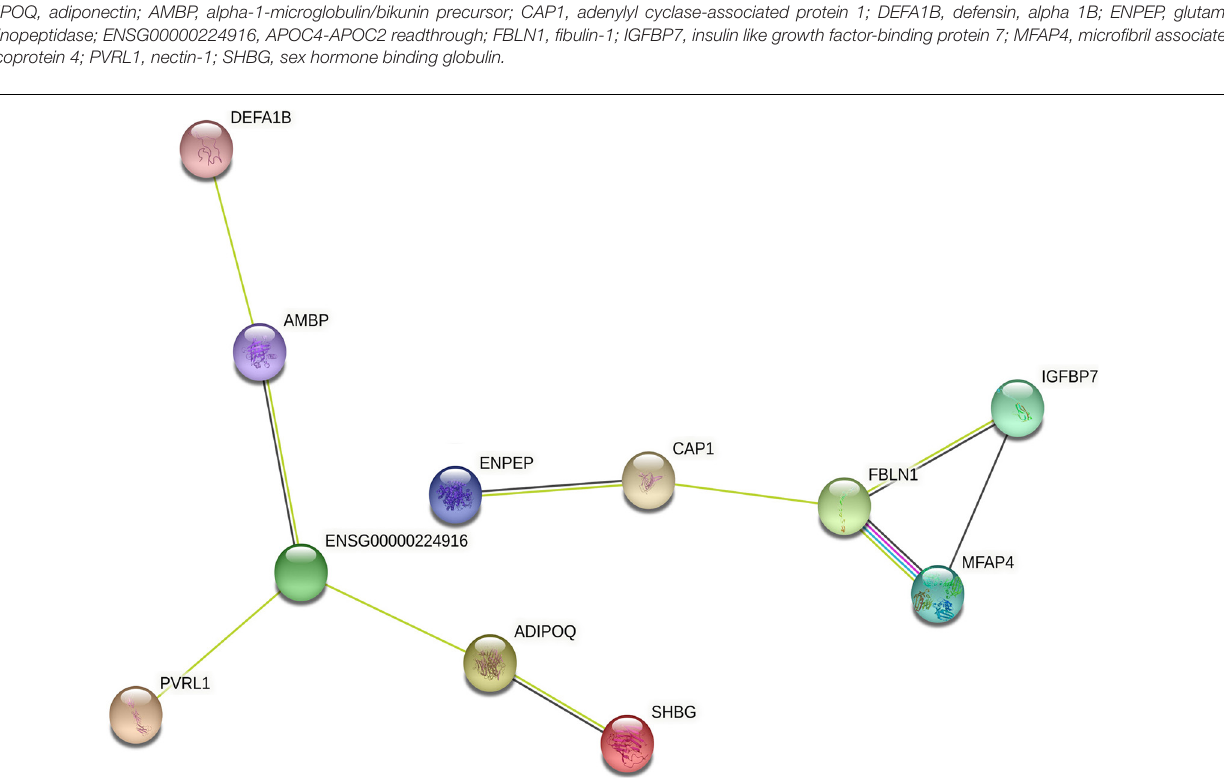
Database Automated Total score determined annotated text mining interaction